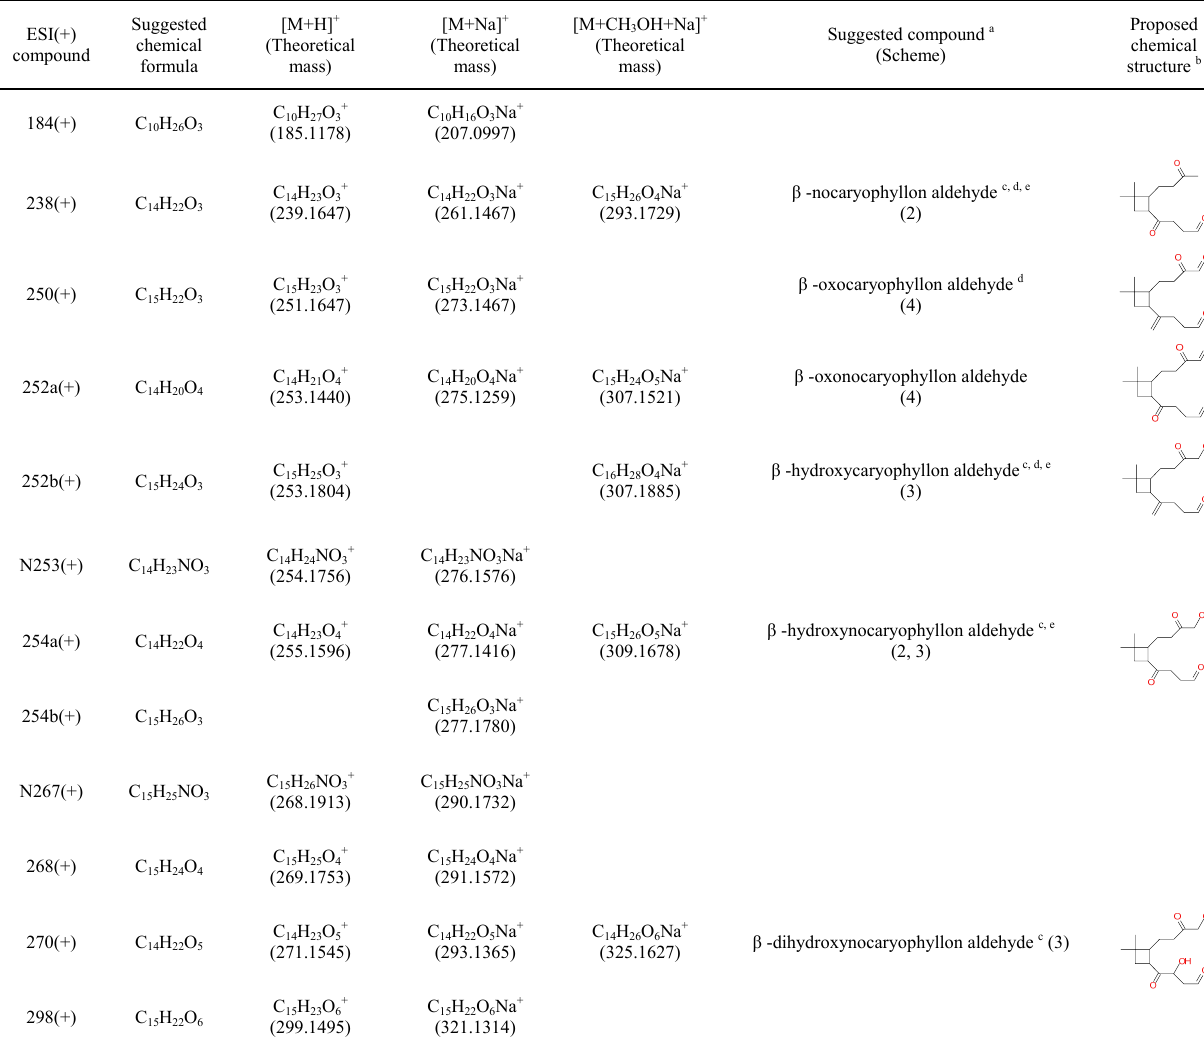
Suggested compound a (Scheme)